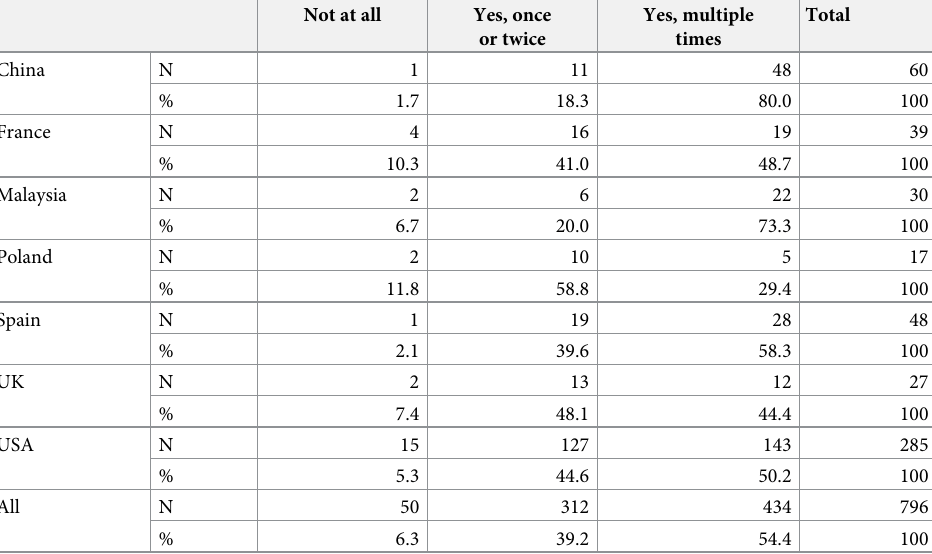
Table 14. Have you attended online/virtual conferences during the pandemic?